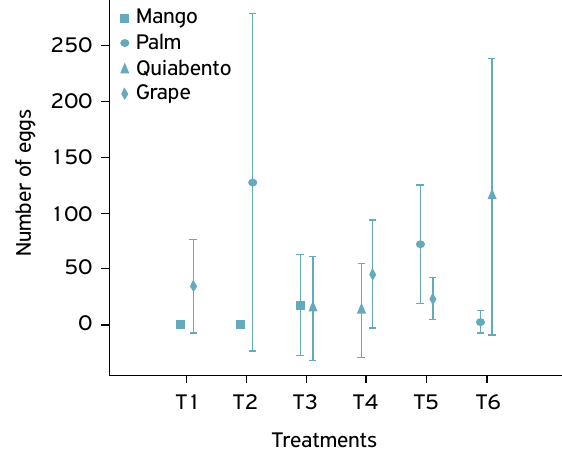
Figure 2. Mean number of eggs C. capitata in fruit of mango, palm, quiabento and grape. Vitória da Conquista, BA,